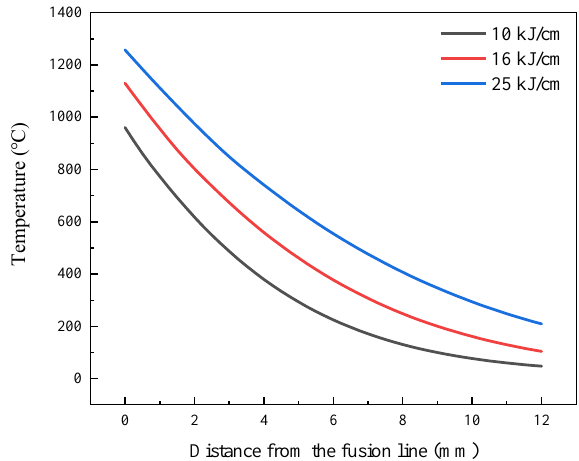
Figure 17. Temperature distribution at a depth of 0.5 mm in the heat affected zone (HAZ) at the end instant of repair welding for different linear energy.